Question: Draft a figure caption describing what is shown.
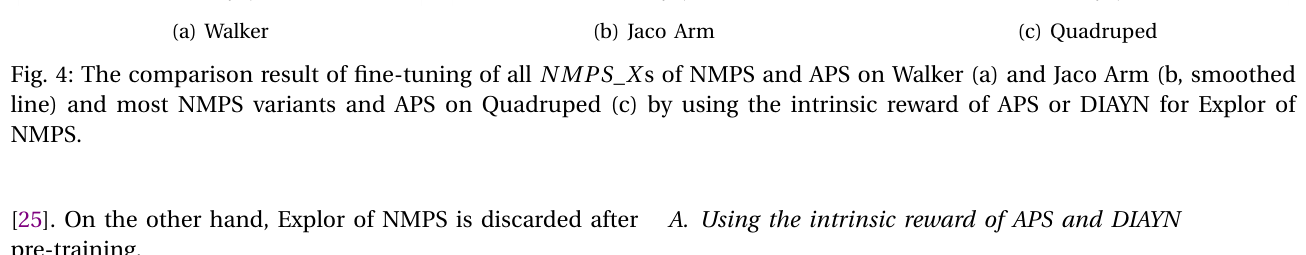
Answer: The comparison result of fine-tuning of NMPS (the best one), APS, DIAYN and SMM on Walker (a), Jaco Arm (b) and Quadruped (c) by using the intrinsic reward of APS or DIAYN for Explor of NMPS.